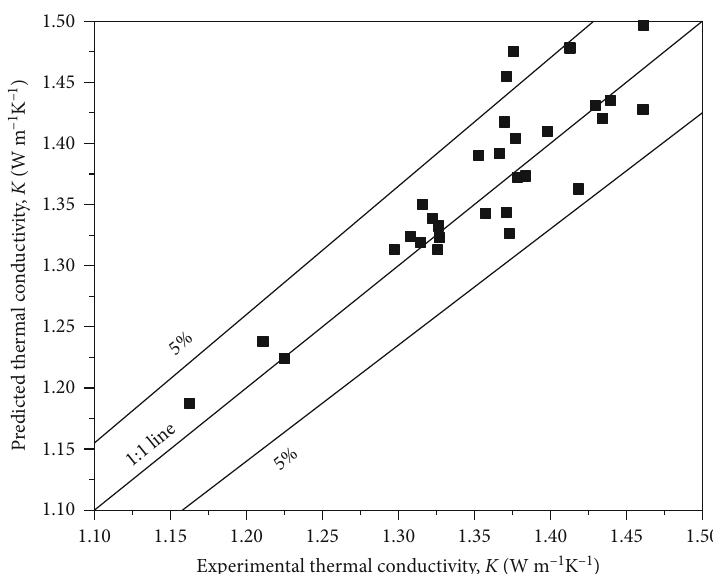
Figure 14: Performance of the K model by comparing predicted thermal conductivities and measured values.